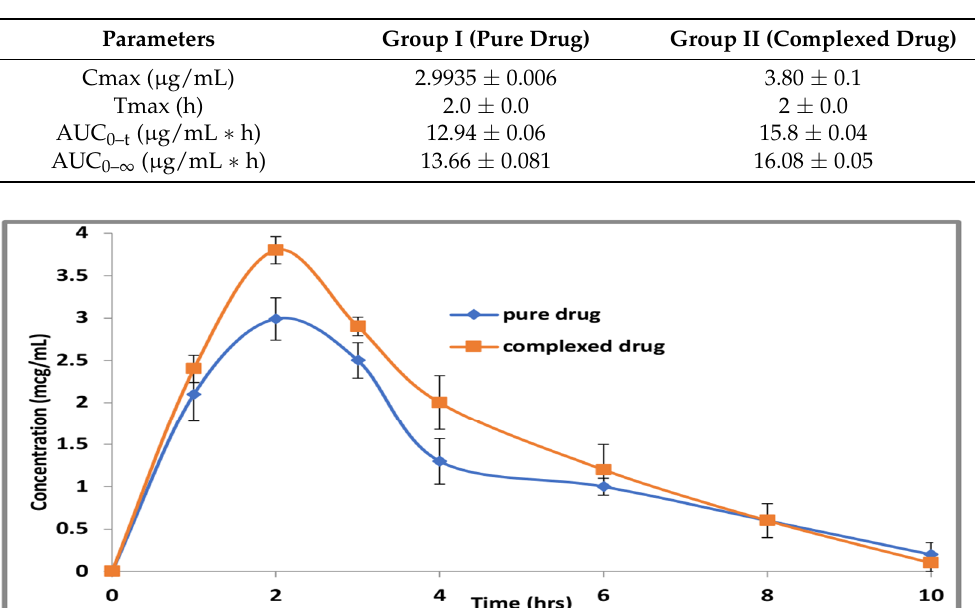
Table 2. The in vivo pharmacokinetic parameters of pure CBZ and complexed CBZ following oral administration in rats.